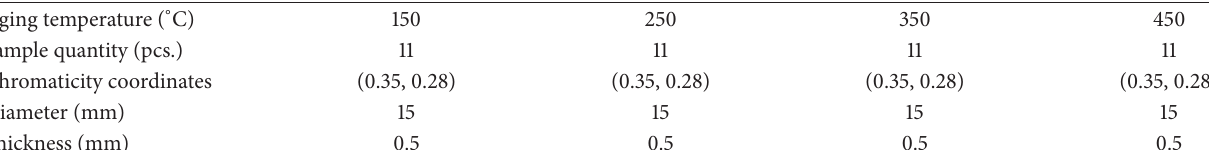
Table 1: High CRI sample counts of accelerated test.